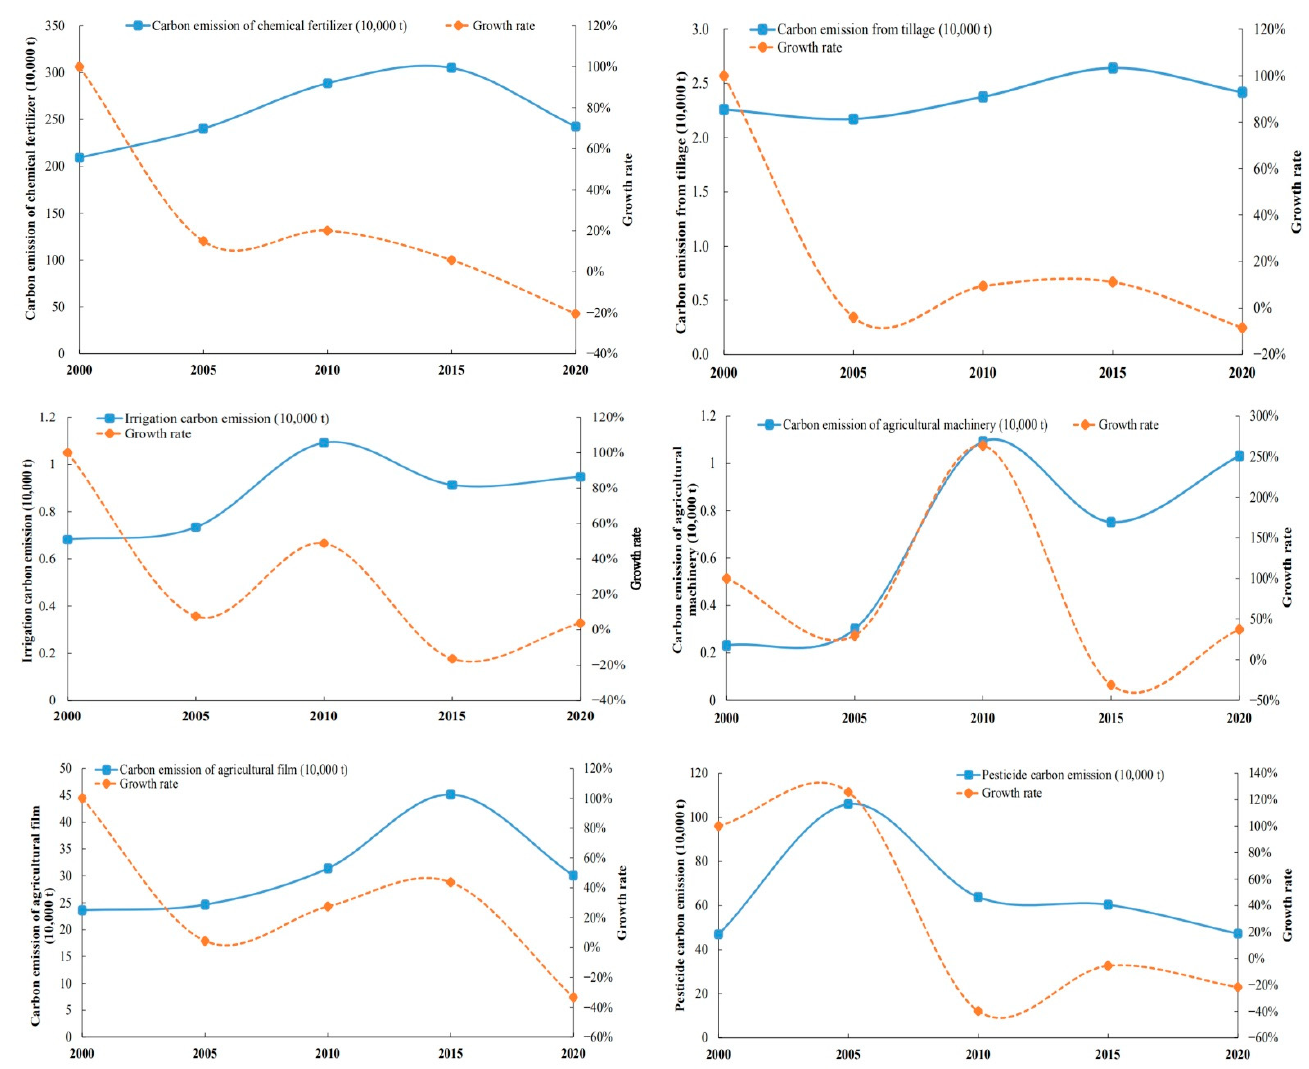
Figure 3. Time series change of carbon emission magnitude growth of different carbon sources.